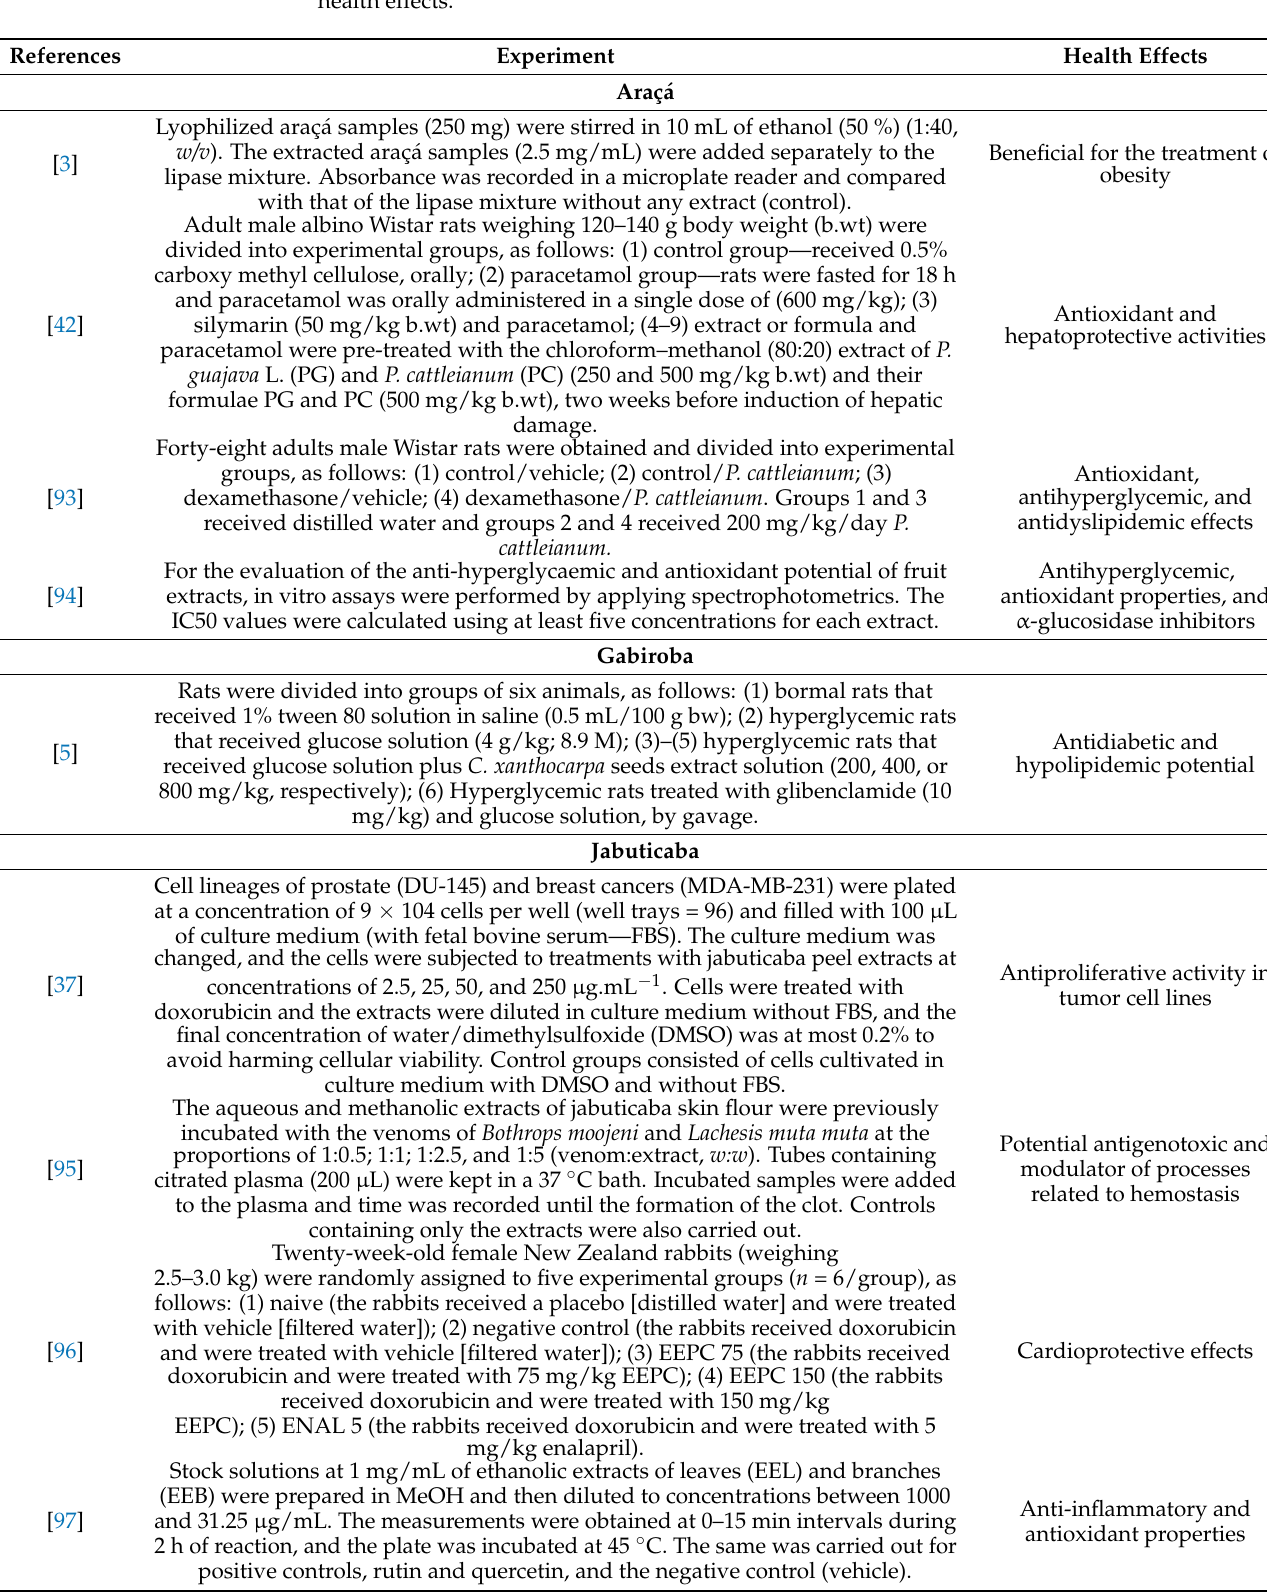
Table 3. Synthesis of selected works with the main flavonoids identified in extracts and their positive health